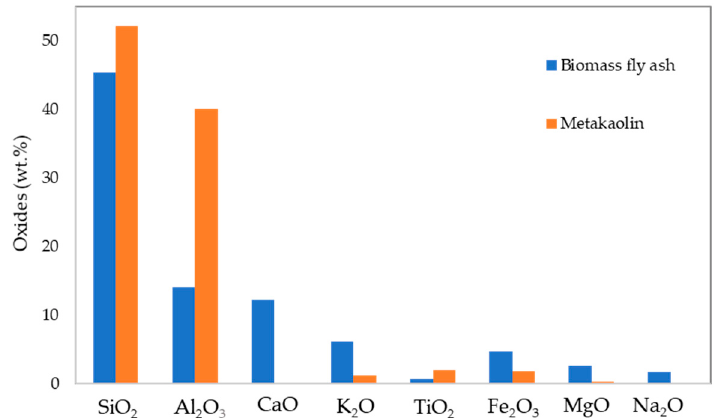
Figure 1. Chemical composition of MK and FA.